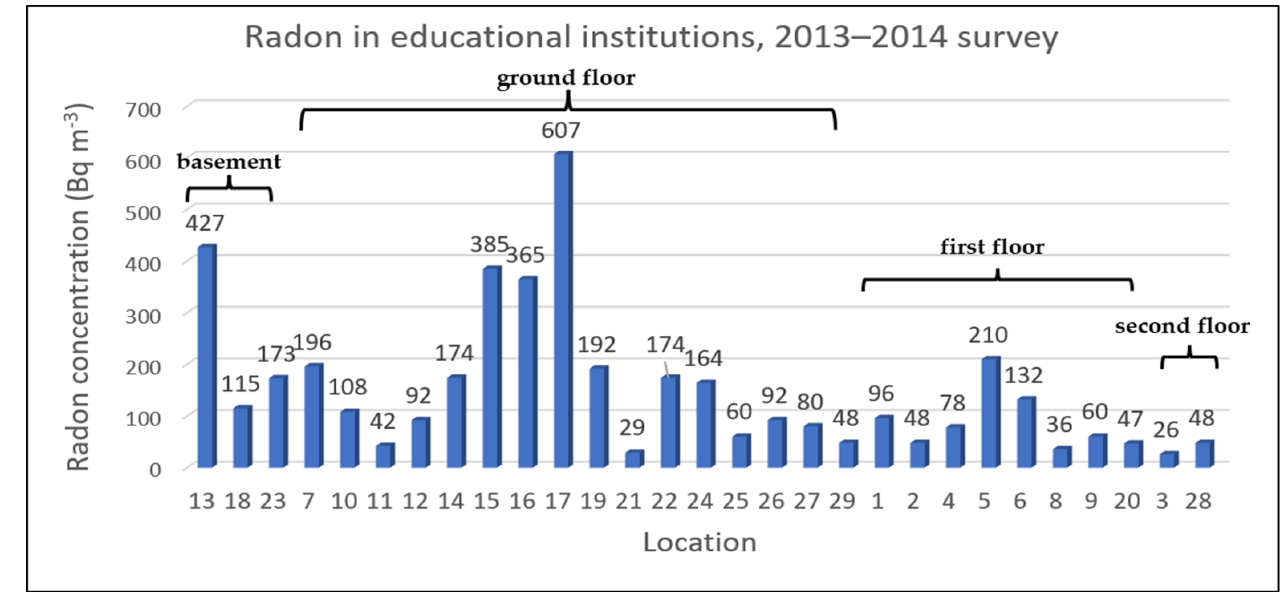
Figure 2. Distribution of radon concentrations in educational institutions of Republic of Moldova during the period of 2013–2014.